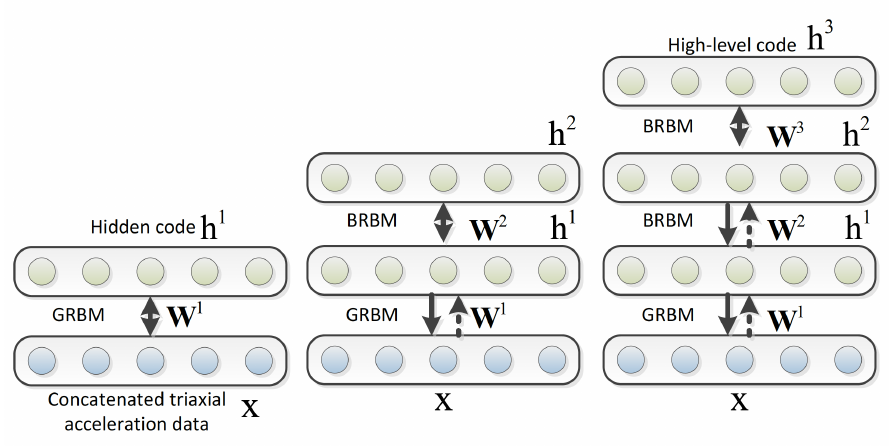
Figure 6. The greedy layer-wise training of DBNs. The first level is trained on triaxial acceleration data. Then, more RBMs are repeatedly stacked to form a deep activity recognition model